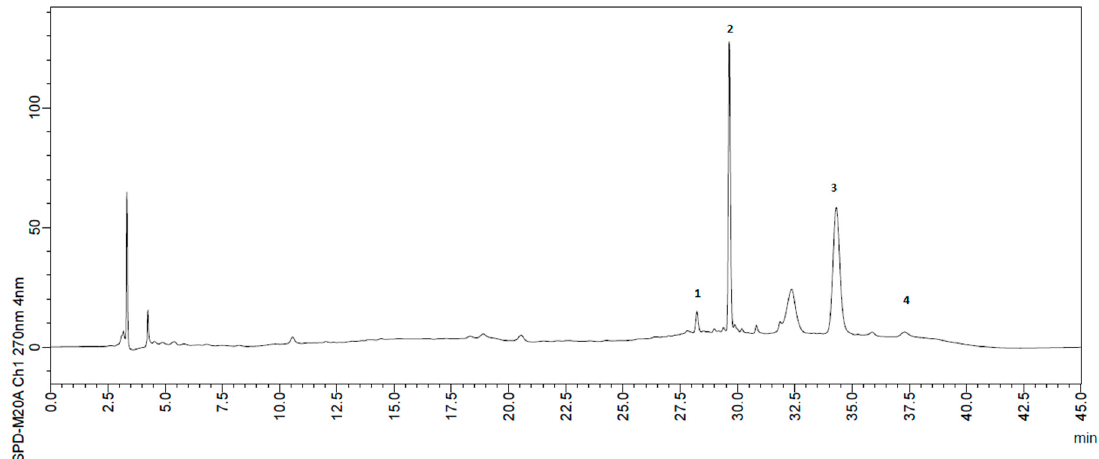
Figure 2. Typical chromatogram for phenolics: 1. p -coumaric acid; 2. ellagic acid; 3. Quercetin; 4. procyanidin